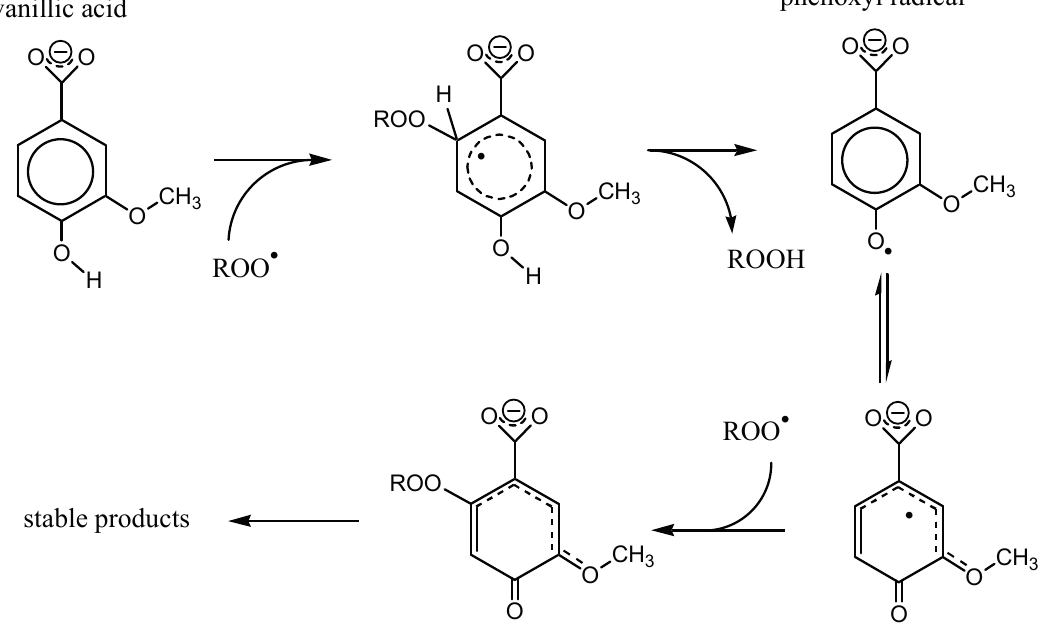
Figure 6. Mechanism of peroxyl radical interaction with p -HB and p -HC acids (Vanillic (VA) as an